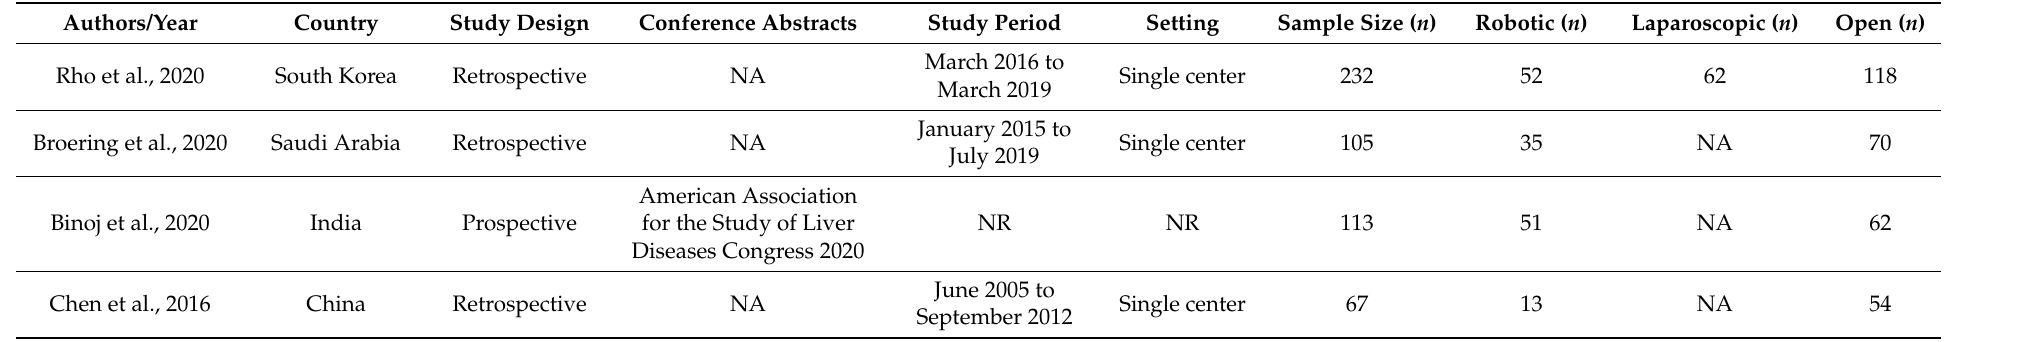
Table 1. General characteristics of included